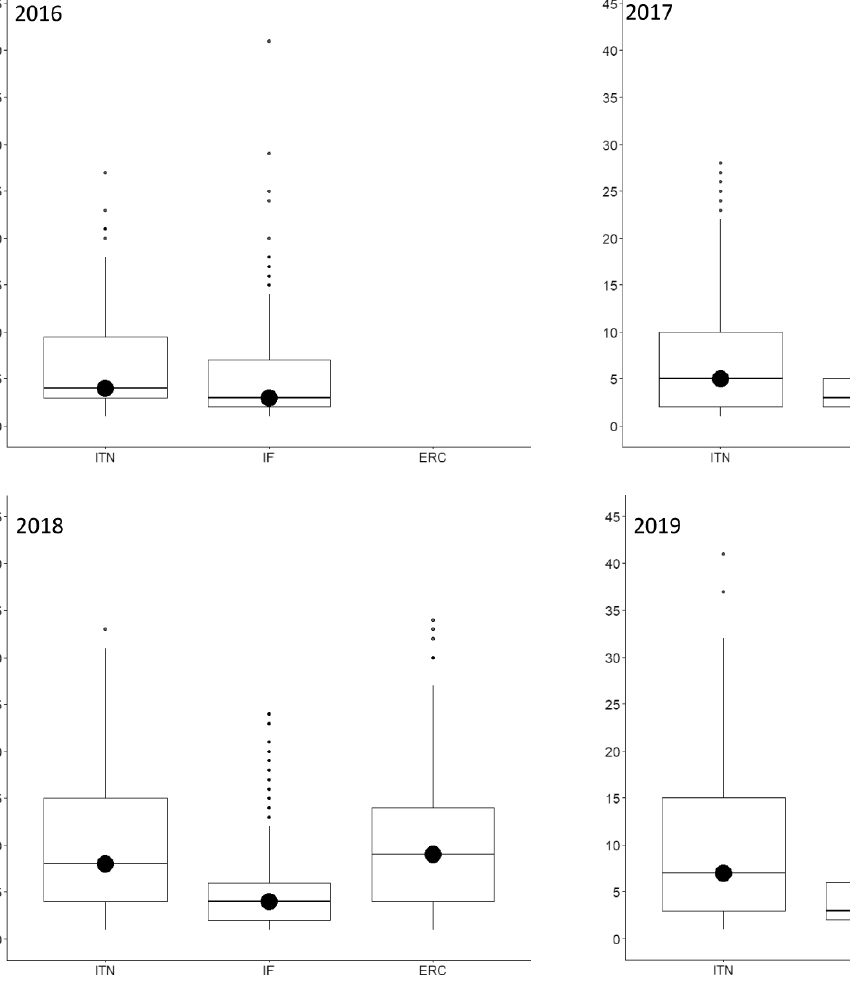
Figure 7. Median number of ethics requirements per proposal, 2016-2019. ITN – Innovative Training Networks, IF – Individual Fellowships, ERC – European Research Council grants. The data are from years available in the SEP tool of the European